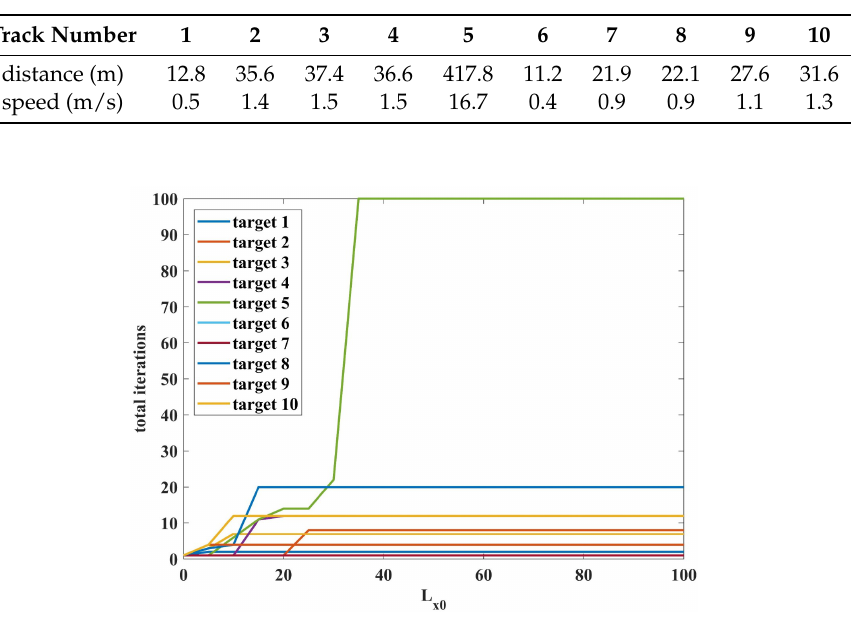
Figure 20. The curve of total tracked iterations of ten clusters versus different L x 0 . Target 5 is the real moving target, the rest is the false